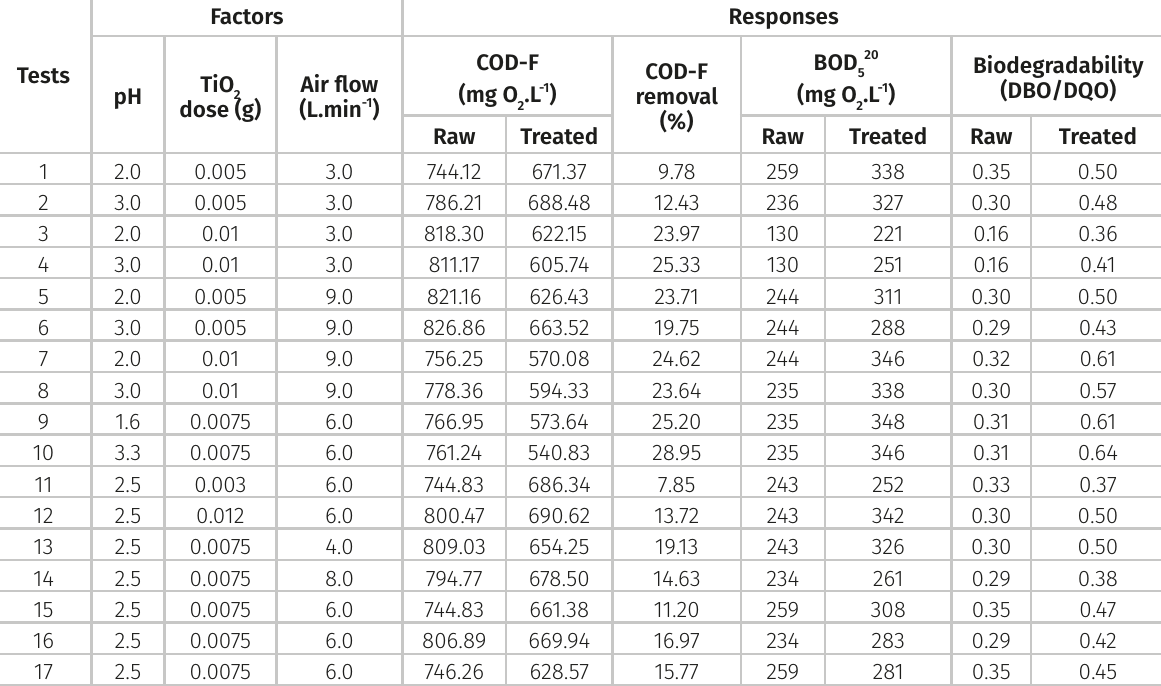
Table VI. Factors and responses obtained according to the variation of the decoded levels and the predicted tests in the factorial planning for photocatalytic ozonation